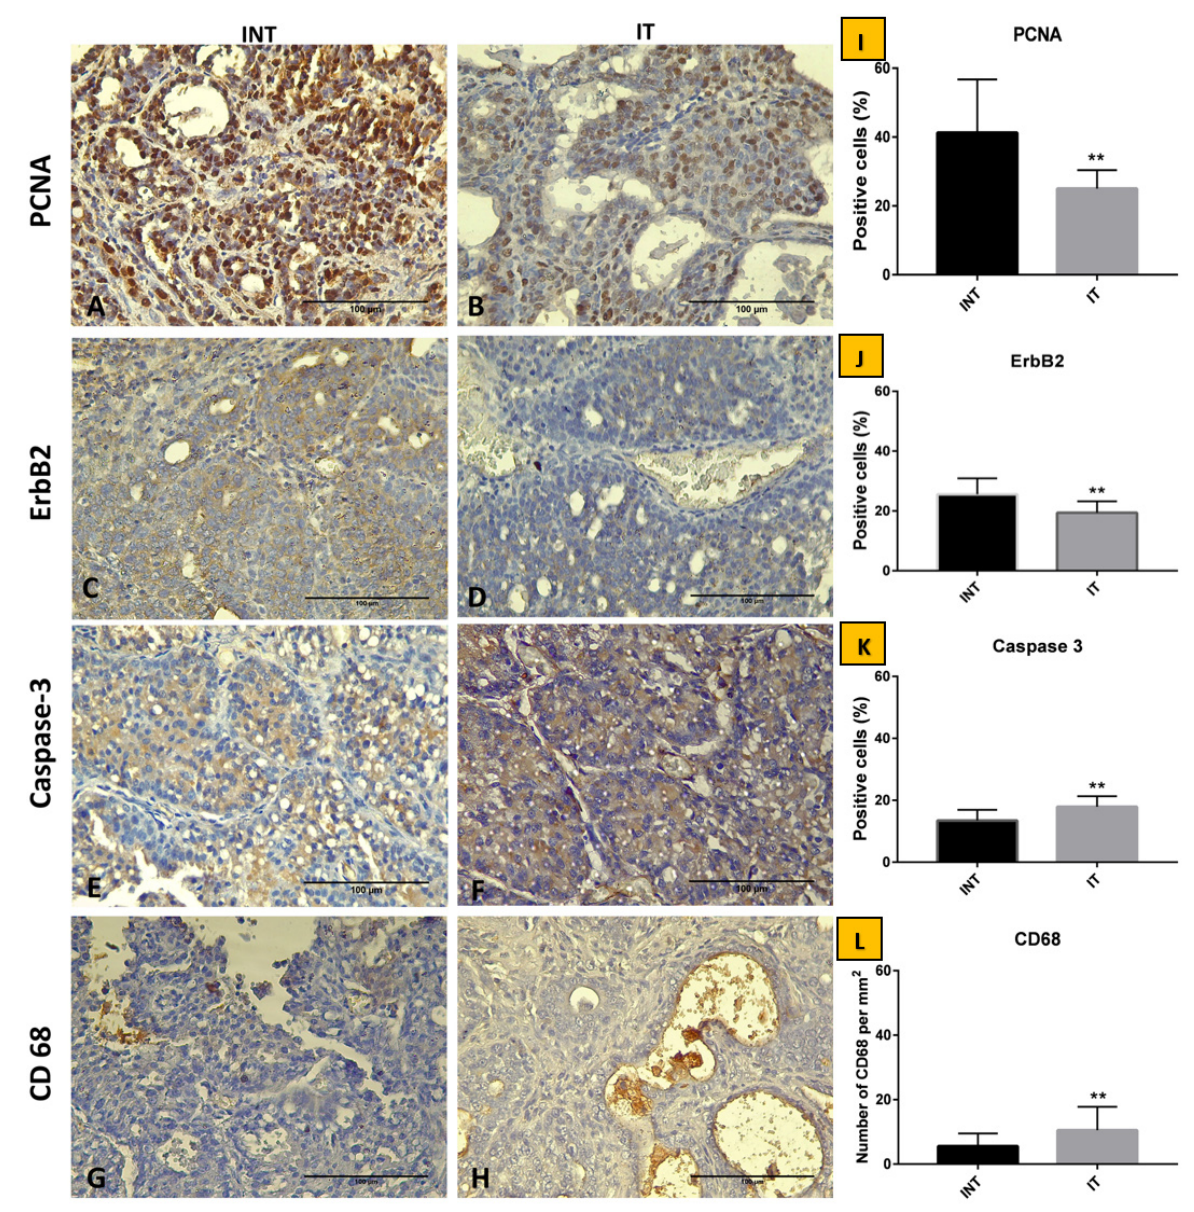
Figure 3. Immunostaining of breast adenocarcinoma tissue sections after ECCT treatment. ( A and B ) Anti-PCNA, ( C and D ) anti-ErbB2, ( E and F ) anti-Caspase-3, ( G and H ) anti-CD68. Percentage of positive cells of ( I ) PCNA, ( J ) ErbB2, and ( K ) Caspase-3 in 50 fields of view. ( L ) Count of total macrophages in 50 fields of view. Observation of histological slide was performed using Leica CC50 E at 0.5 µm/pixel resolution at 400x. Bar=100 µm. The mean, standard deviation of the data experiment show *, p<0.05, **, p<0.01. INT= DMBA-induced rats without EF therapy, IT= DMBA-induced rats with EF therapy exposure.